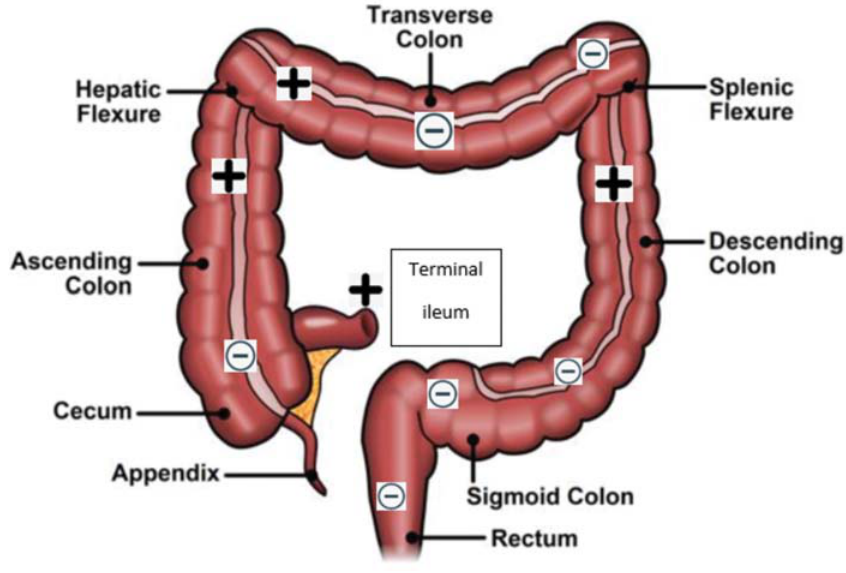
Fig. 2 Results of colonic mapping at the time of ileostomy creation, showing Hirschsprung disease with skip lesions. ( þ ) denotes presence of ganglion cells. ( – ) denotes absence of ganglion